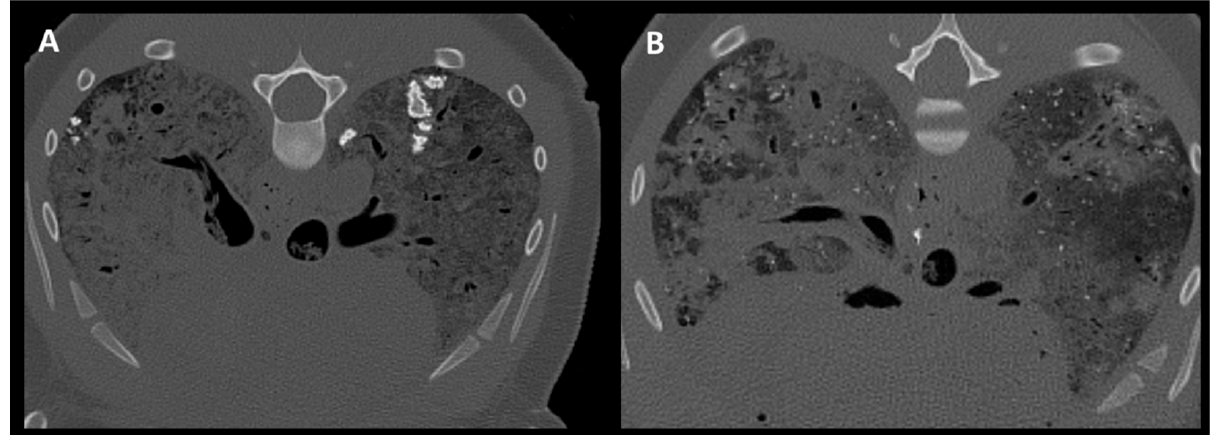
Figure 5. Two PMCT patterns of pulmonary mineralization. ( A ) Singular medium to large irregular shaped mineral attenuating areas, associated with a (nodular) consolidated region. ( B ) Multifocal distributed pinpoint mineral attenuating foci throughout the lung parenchyma.